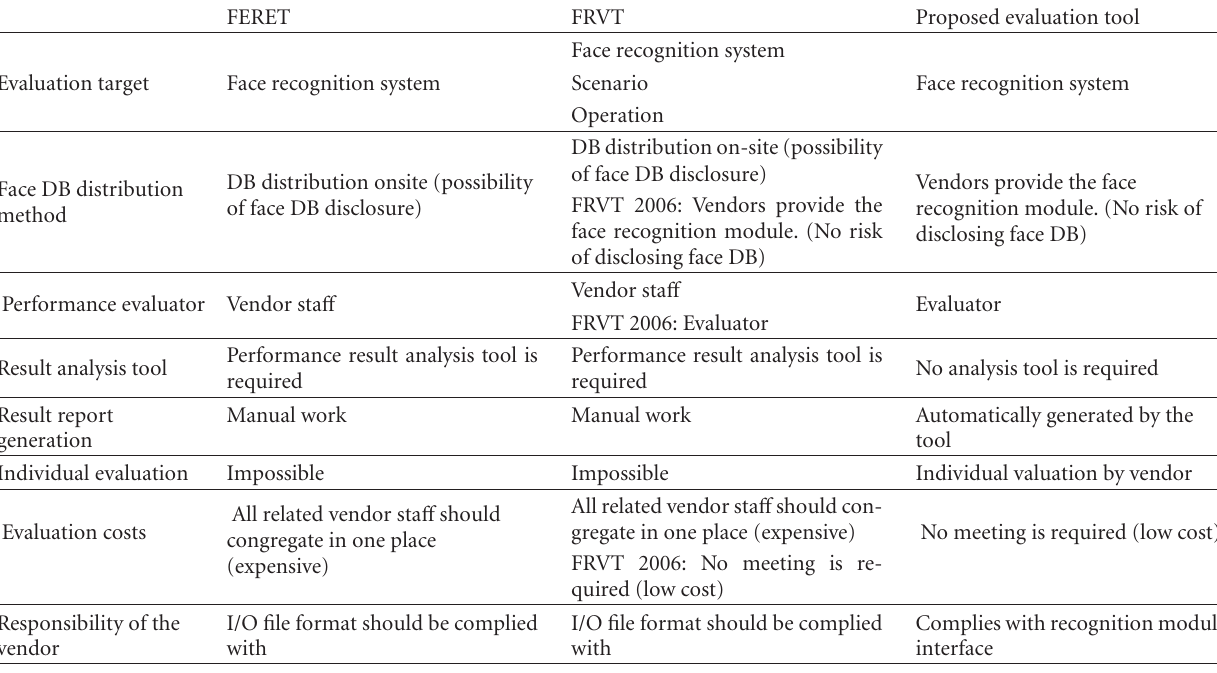
Table 5: Comparison between evaluation methods (FERET, FRVT, and the proposed performance evaluation